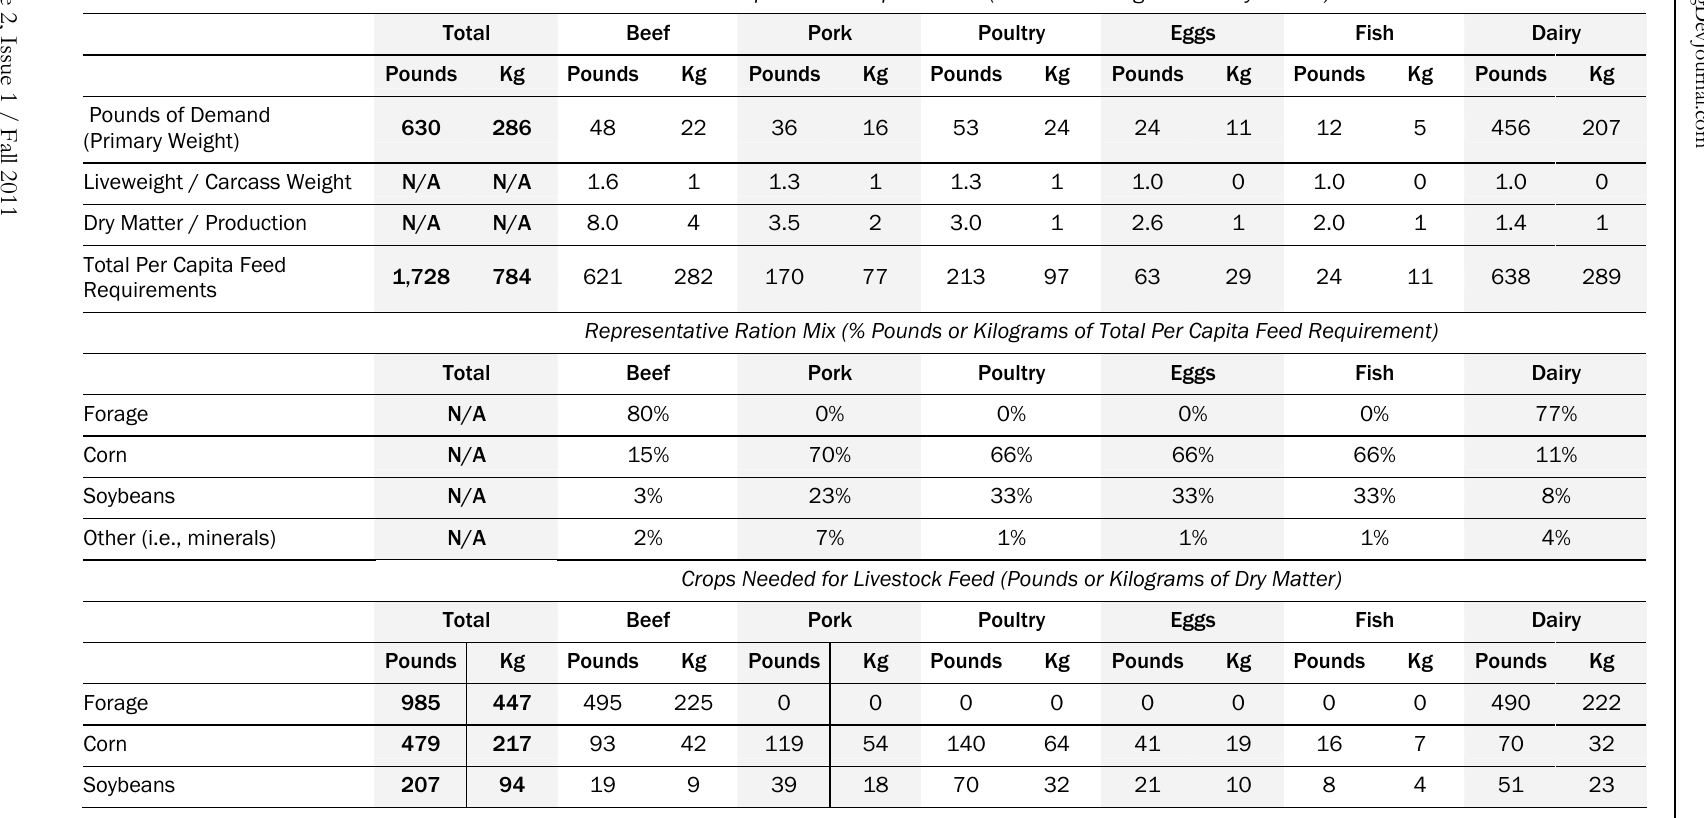
Table 4. Livestock Conversion Rates